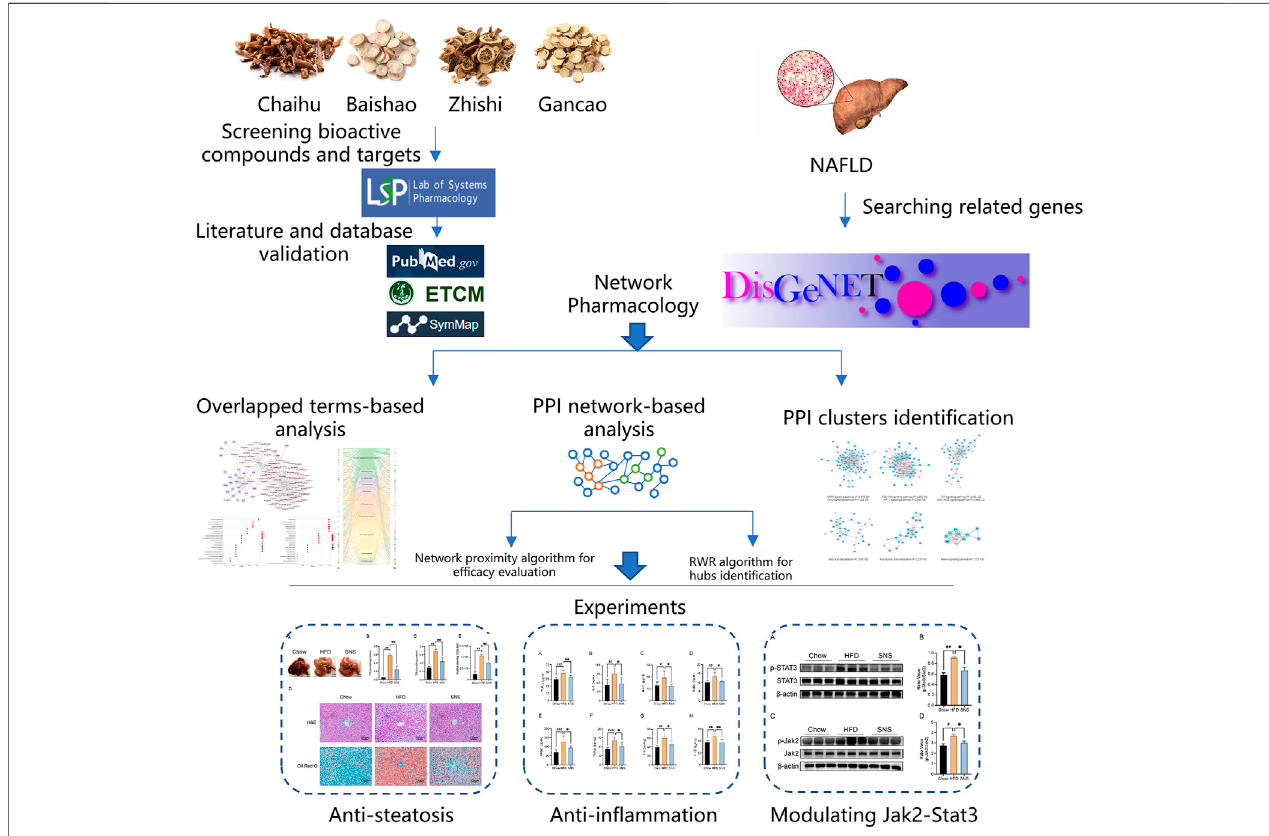
FIGURE 1 | Integrated work fl ow for discovery of the potential mechanisms of SNS against NAFLD.